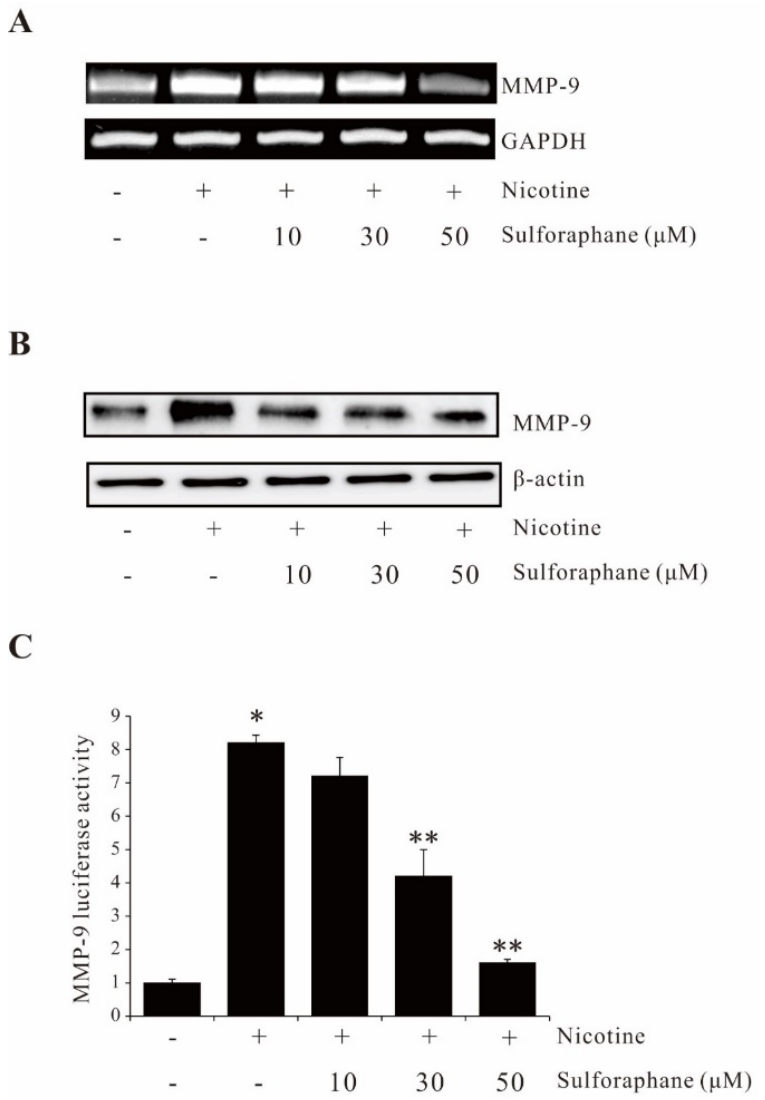
Figure 1. Sulforaphane inhibits nicotine-induced MMP-9 expression in human gastric AGS cells. AGS cells were pretreated with sulforaphane (10, 30, 50 µ M) for 1 h, followed by treatment with 100 µ g/mL nicotine for 4 h or 12 h, and MMP-9 expression was analyzed by performing RT-PCR ( A ), Western blot ( B ), and luciferase activity assay ( C ), respectively. The data represent the mean ± SEM from three experimental trials. * p < 0.05 in comparison with the control; ** p < 0.05 in comparison with nicotine alone.